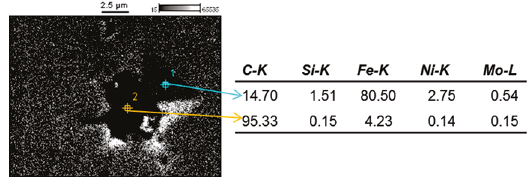
Figure 2. SEM image and EDS analysis of a graphite nodule.